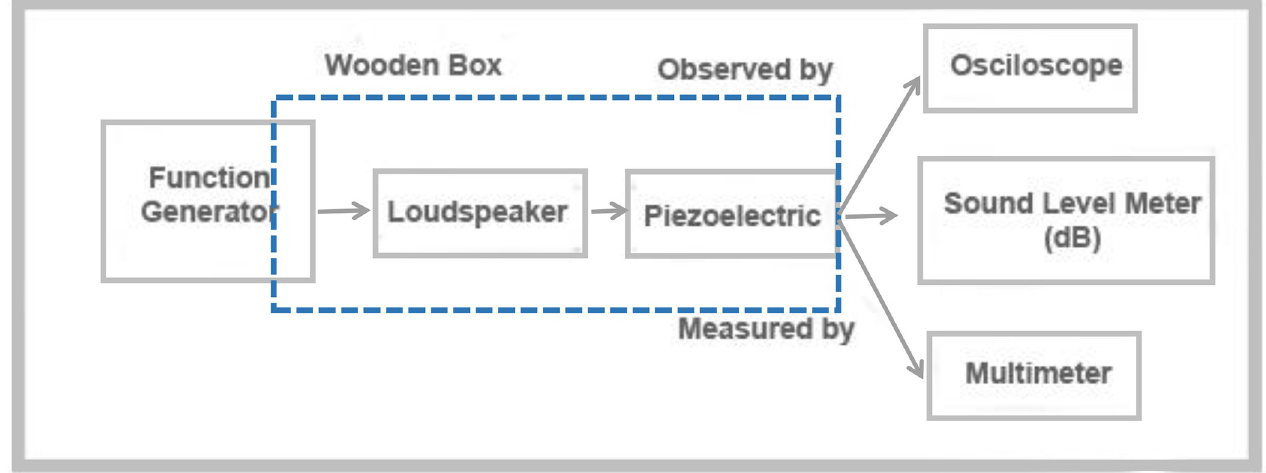
Fig 1. The experimental setup for characteristics of the piezoelectric strip harvester on sound wave [22].